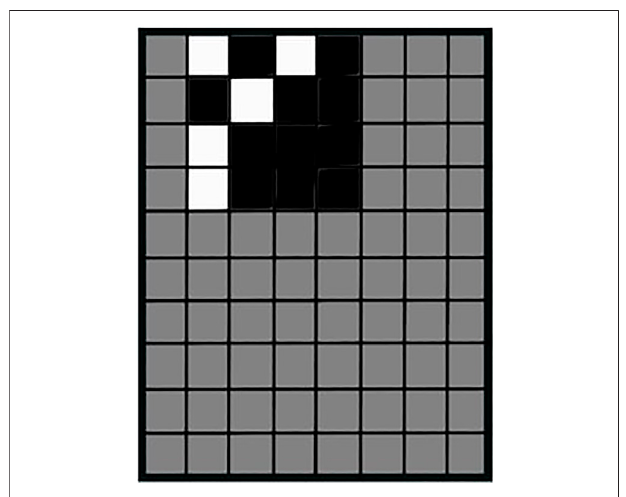
FIGURE 8 | Watermark pattern, fi gure adapted from the study by Li H. et al. (2019).